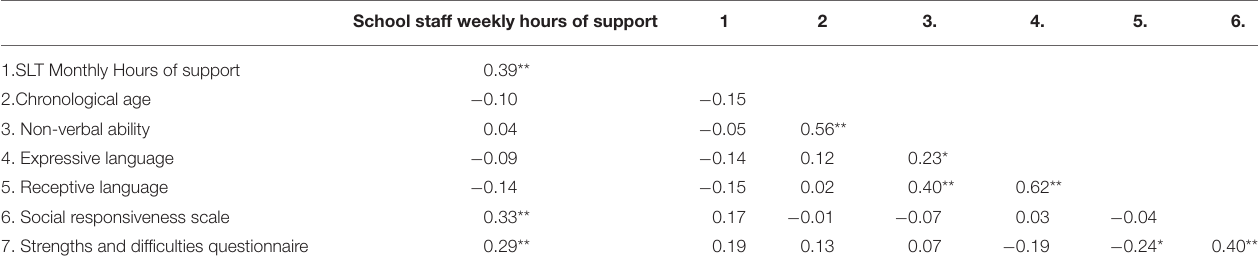
TABLE 4 | Correlations between hours of support provided and scores on non-verbal ability, oral language, social responsiveness, and behavior a . School staff weekly hours of support